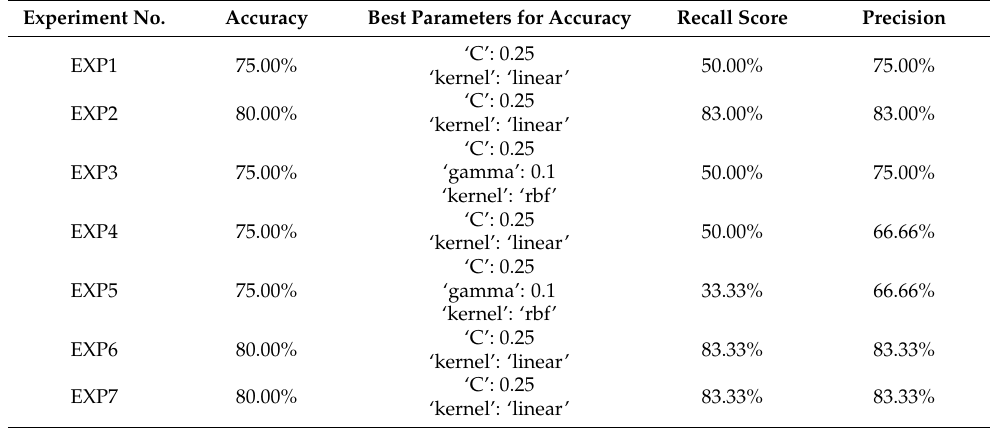
Table 2. Performance analysis of SVM classifier on different combinations of selected measurements. Experiment